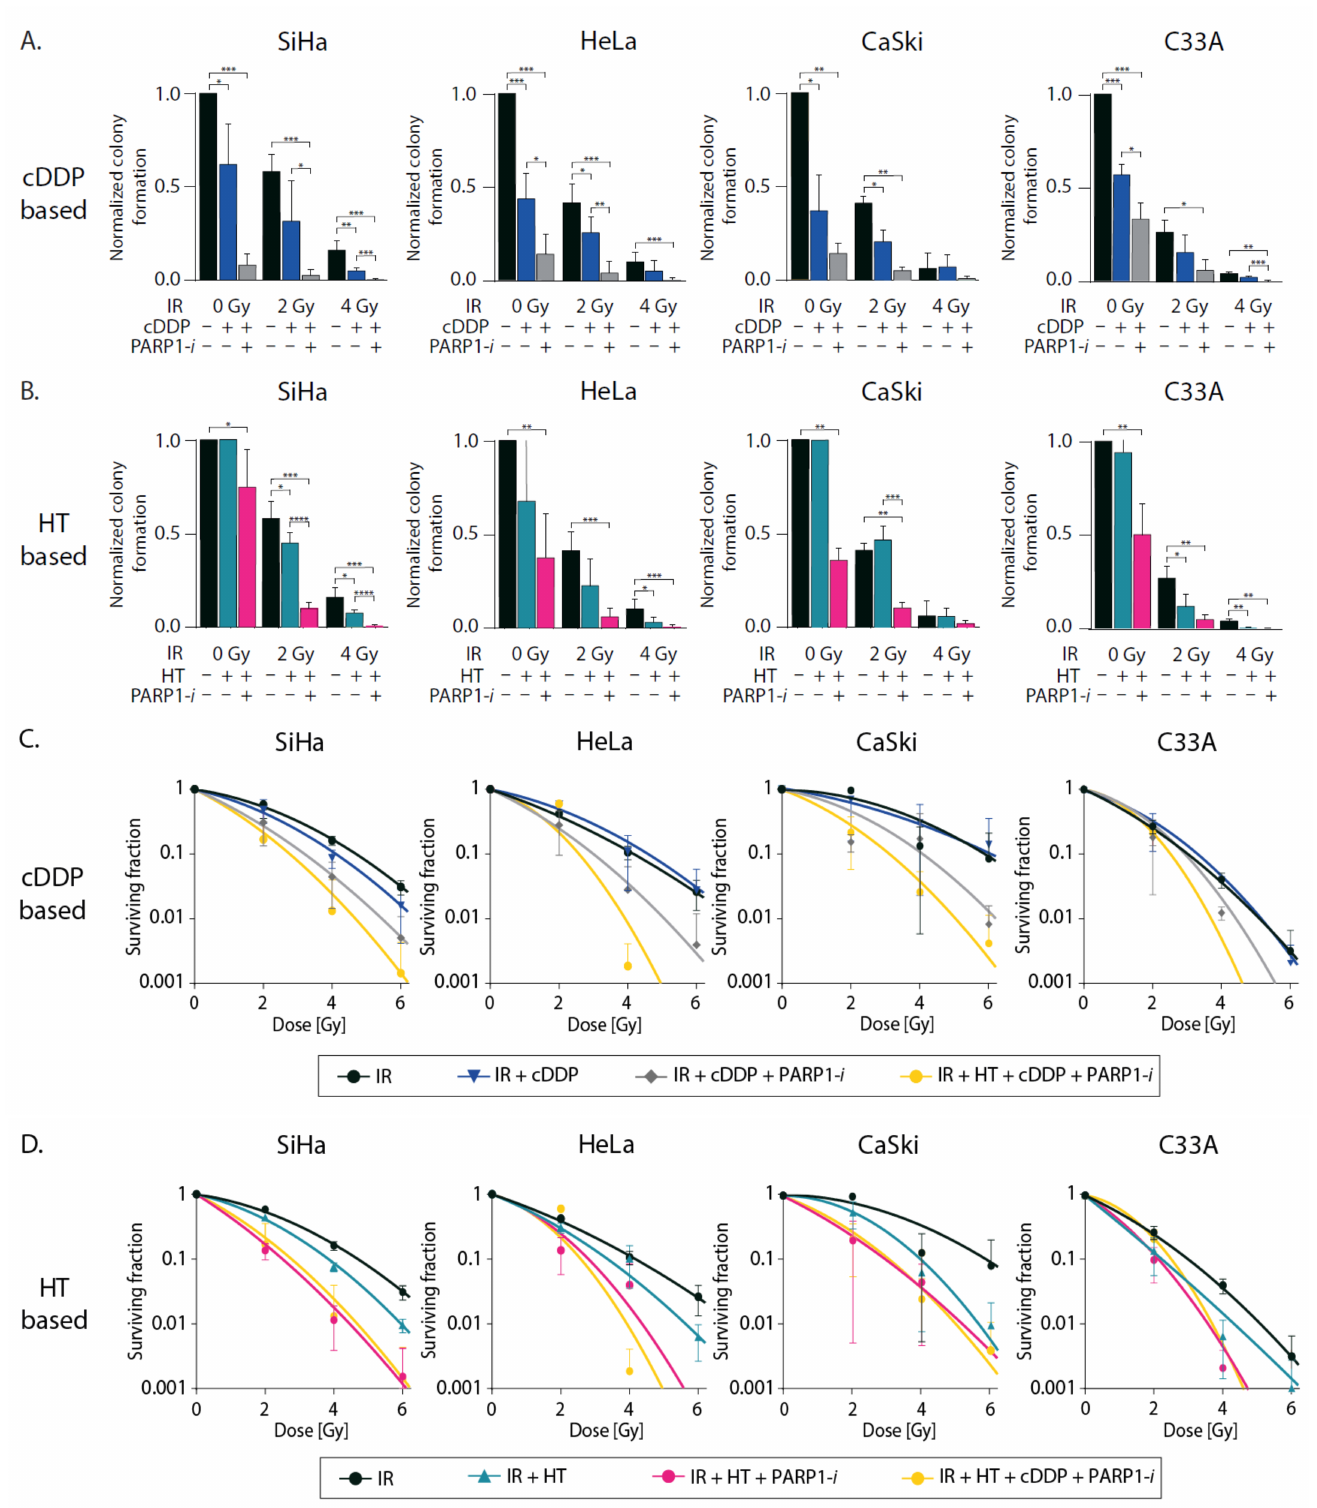
Figure 1. In vitro response to ionizing radiation (IR), cisplatin (cDDP), hyperthermia (HT) and PARP1-inhibition (PARP1- i ) as single and combinational treatments in four cervical cancer cell lines (SiHa, HeLa, CaSki and C33A). ( A ) Normalized colony formation after IR in combination with cDDP or ( B ) with HT. ( C ) Clonogenic survival graph after IR in combination with cDDP or ( D ) with HT. * p < 0.05, ** p < 0.01, *** p < 0.001, **** p <0.0001 compared to corresponding controls. Independent samples t